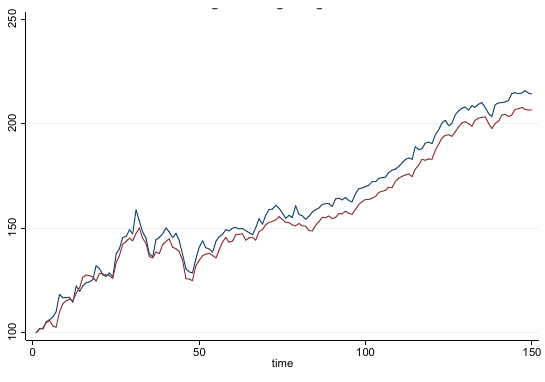
Figure 2. Age segments. Note: The apartment price index. The Stockholm housing market and segments of the market (the x ‐axis is the measuring price index and the y ‐axis is the measuring time). The red line is equal newer apartment and the blue is equal older apartments.